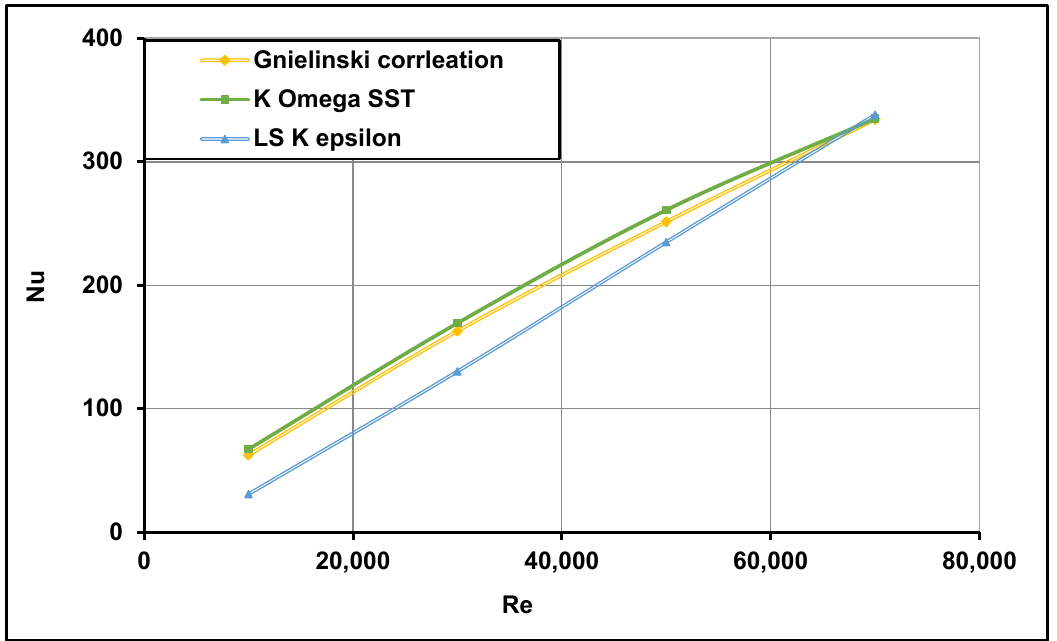
Figure 7. Mesh independence study for the solar receiver with a single straight conical strip insert.